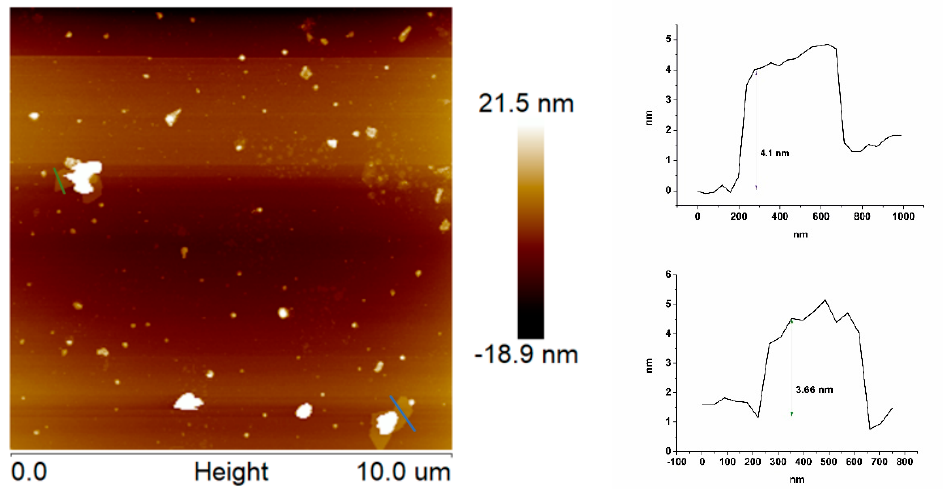
Figure 3. Atomic force microscopy (AFM) topography of h-BN nanosheets and the corresponding height profiles.